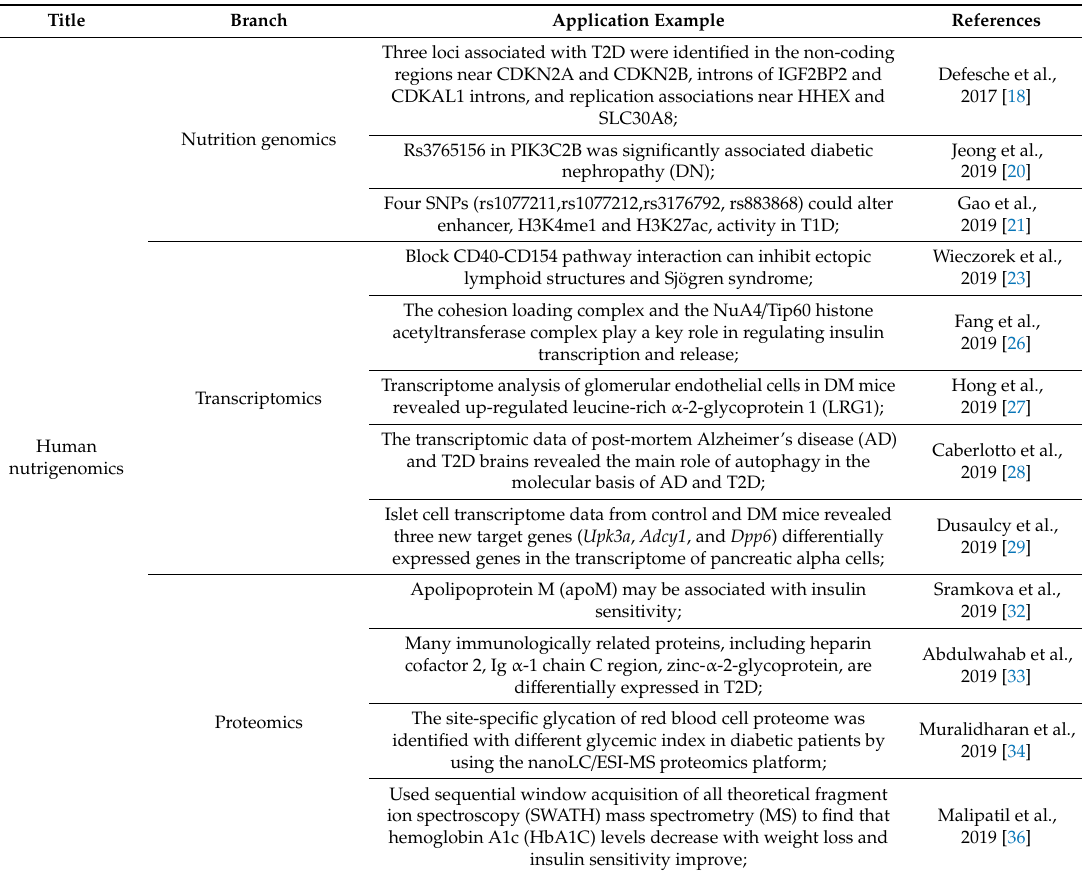
Figure 2. The application of human nutrition on diabetes mellitus (DM) research. Table 1. Advances in research on human nutrition in diabetes mellitus